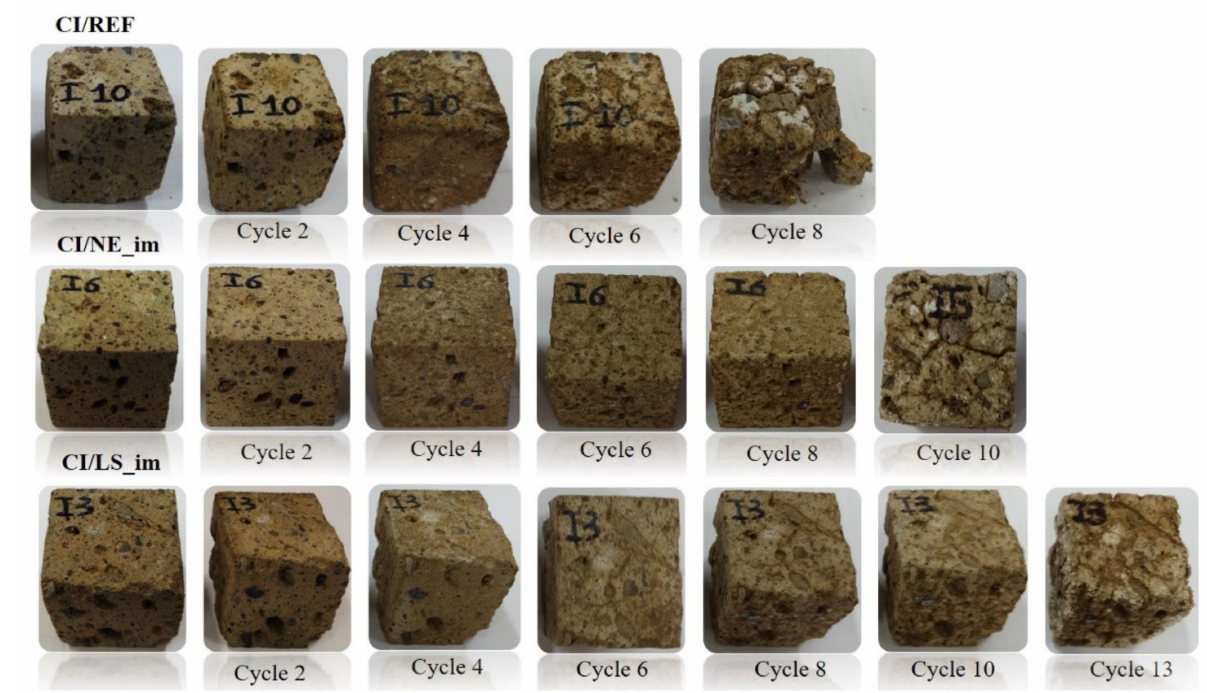
Figure 13. CI samples during salt crystallization